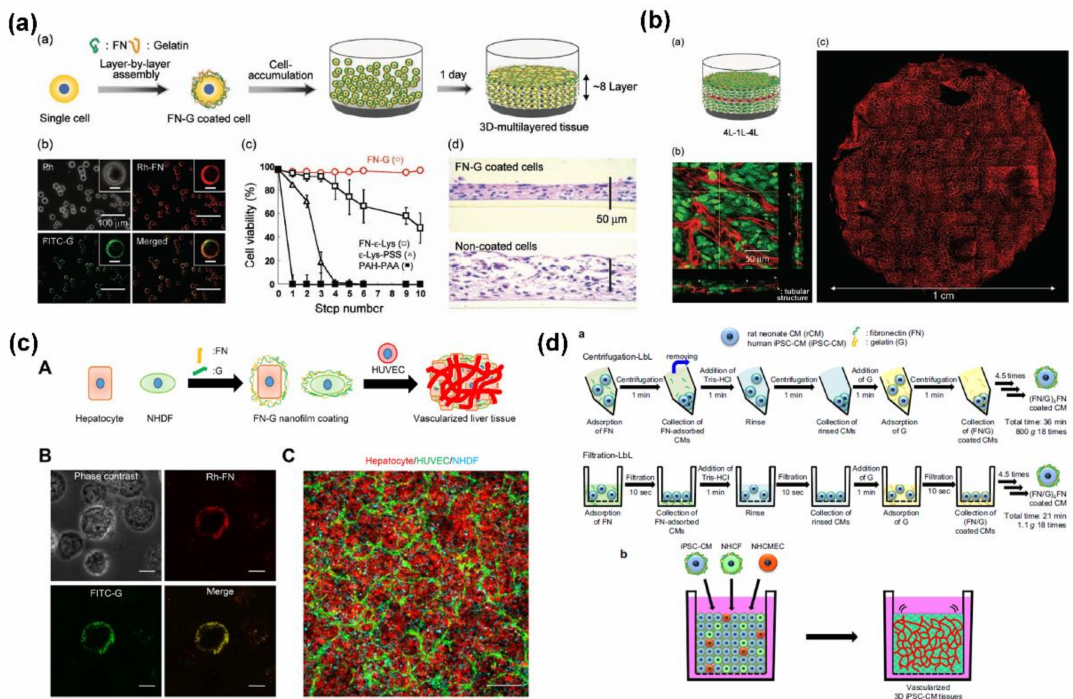
Figure 8. ( a ) Rapid construction of 3D multilayered tissues with endothelial tube networks by the cell-accumulation technique and the phase/fluorescent microscopic images, cell viability, and hematoxylin and eosin staining images of the resultant tissues; ( b ) schematic illustration, cross-section image, and reconstructed fluorescent image of 3D multilayered tissues; ( c ) the construction of vascularized liver tissue using LbL cell coating technique; ( d ) schematic illustrations of centrifugation-LbL and filtration-LbL for nanofilm coating on cell surfaces, and construction of vascularized 3D tissues by the cell accumulation technique. Reprinted from [112–114] with permissions from Wiley-VCH and